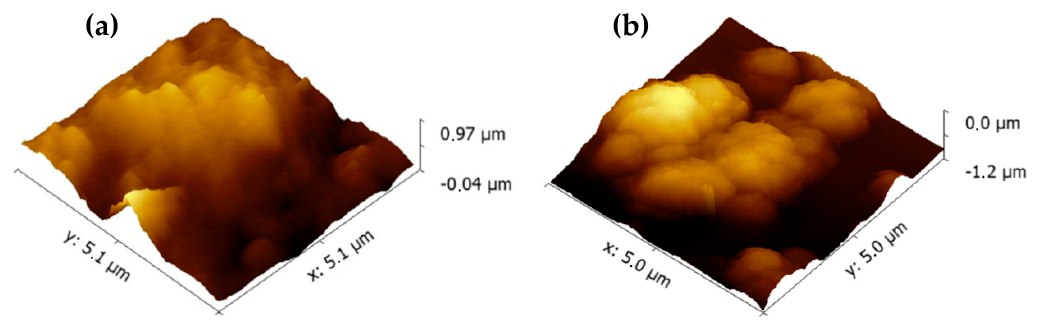
Figure 5. SEM images with different magnifications of GO ( a , b ) and rGO ( c , d ) sheets.